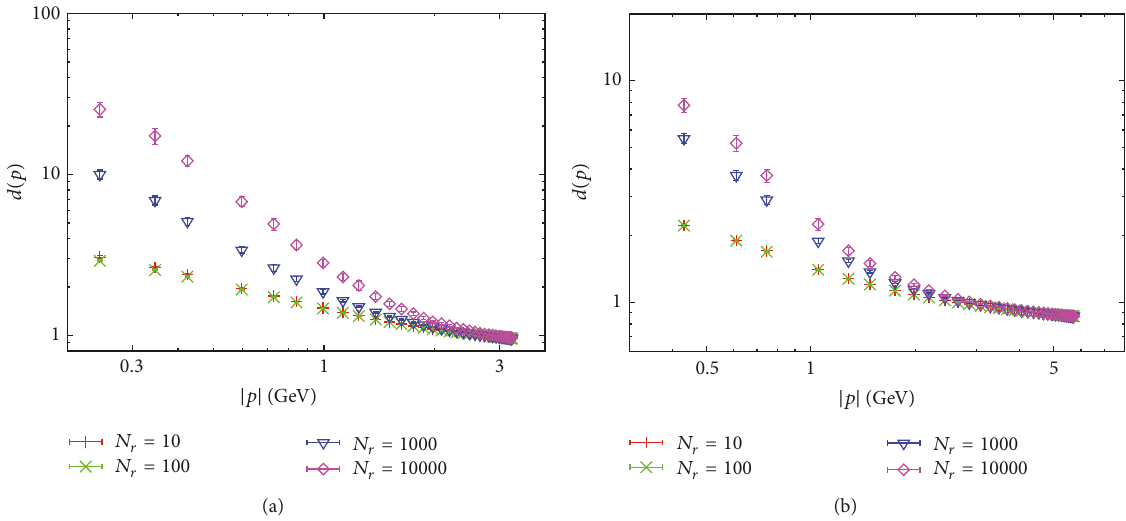
Figure 8: The ghost form factor after gauge fixing to the lowest-eigenvalue copy with increasing number of trials from 10 to 10000 on 24 4